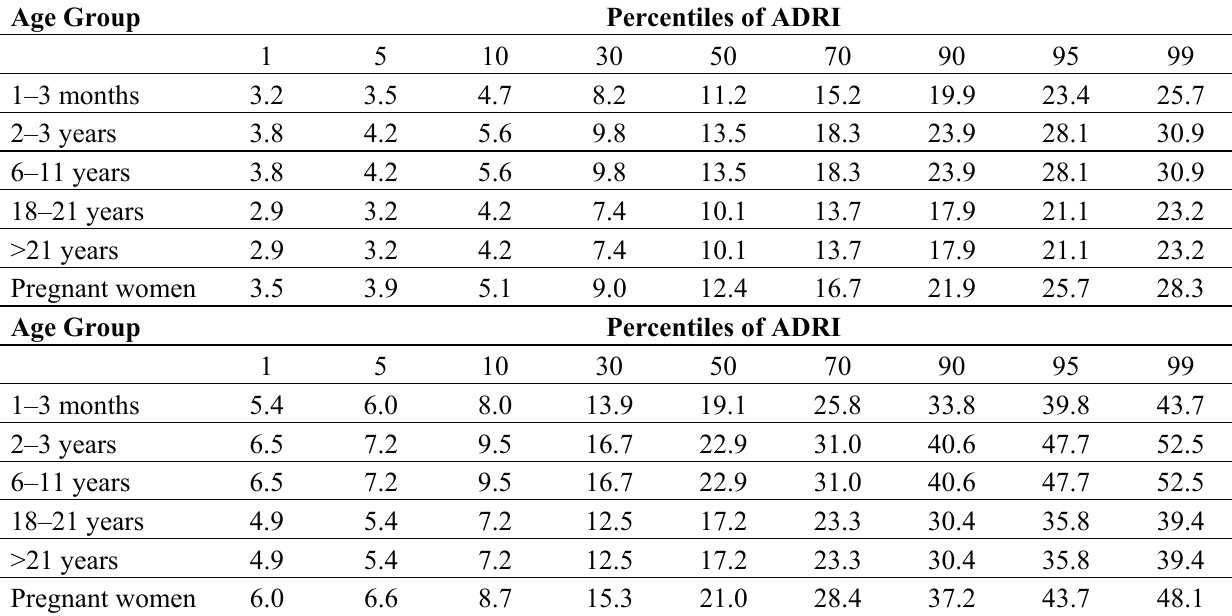
Table 1. Average Daily Rate of Intake (ADRI) values associated with the indicated percentiles of the inter-subject probability density functions (PDFs) as shown in the top row. All values are in units of µg/kg-day Perchlorate Equivalent Concentration (PEC). Separate values are provided by age groups. The upper table contains the results without serum half-life correction, and the lower table presents the same results with serum half-life